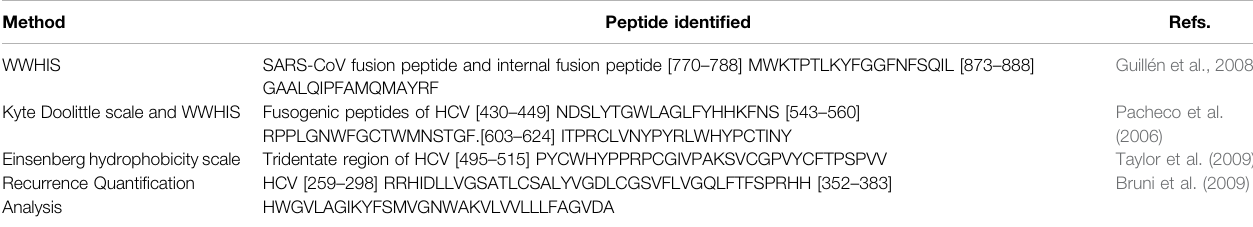
TABLE 2 | Peptides identi fi ed with fusogenic